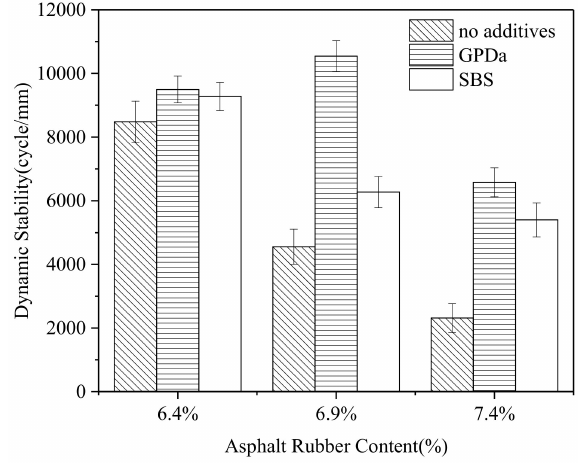
Figure 2. Dynamic stability of mixtures with di ff erent asphalt rubber contents (ARCs) and di ff